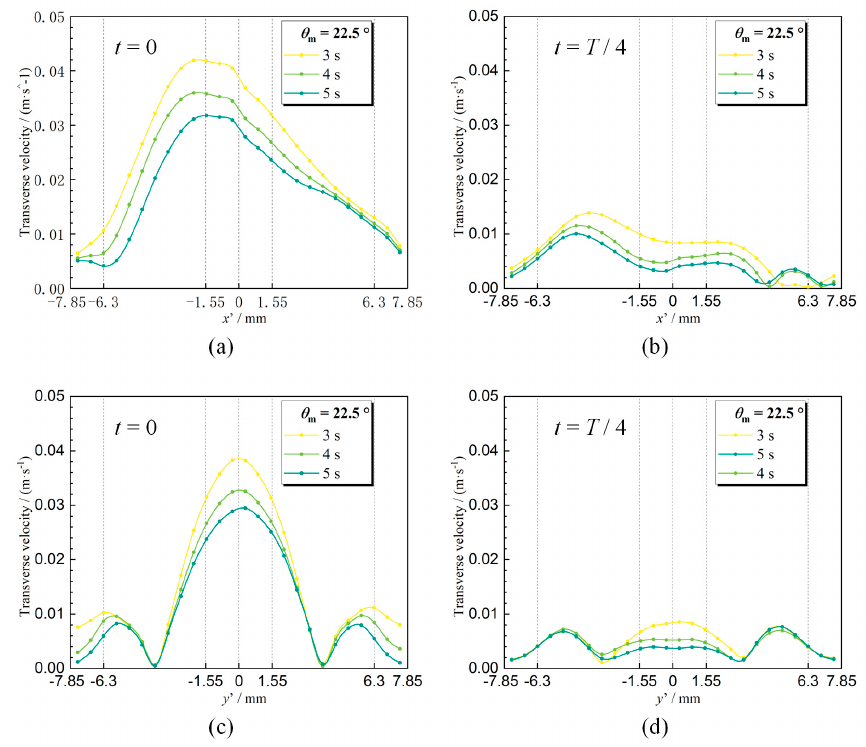
Figure 11. Effect of the period on the transverse velocity. Transverse velocity on the 𝑥’ -axis at ( a ) 𝑡 = 0 and ( b ) 𝑡 = 𝑇/4 ; ( c ) transverse velocity on the 𝑦’ -axis at ( c ) 𝑡 = 0 and ( d ) 𝑡 = 𝑇/4 .